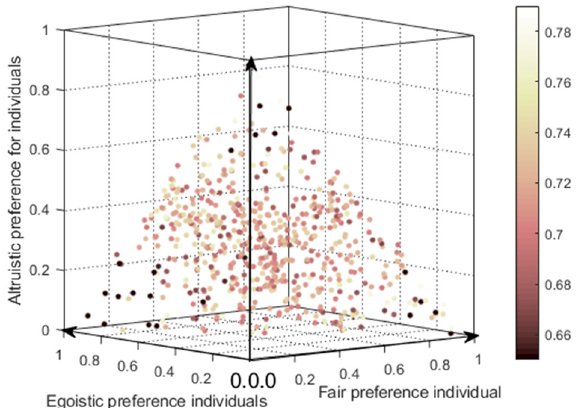
Figure 14. The influences of different preference proportions on the polarization after 100 experiments.